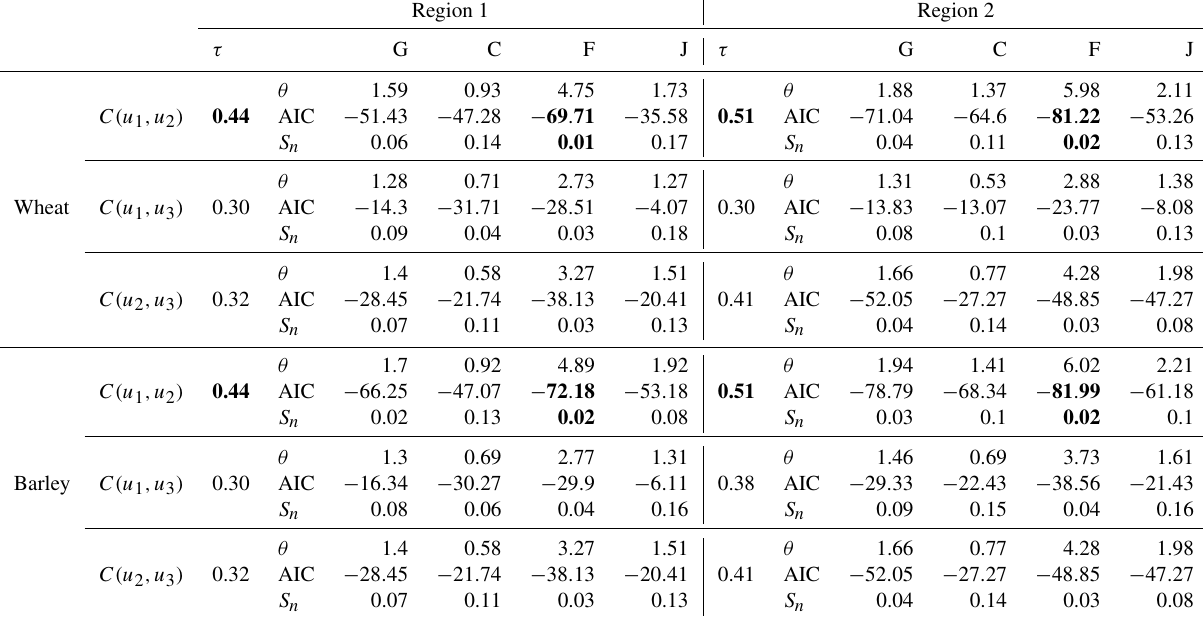
Table A1. As in Table 2 with respect to the possible bivariate pairs of crop yield ( u 1 ), precipitation ( u 2 ) and maximum temperature ( u 3 ) and corresponding Kendall’s’ correlation ( τ ). Maximum values of τ are denoted in bold for each cereal and region indicating the pair of variables with the strongest